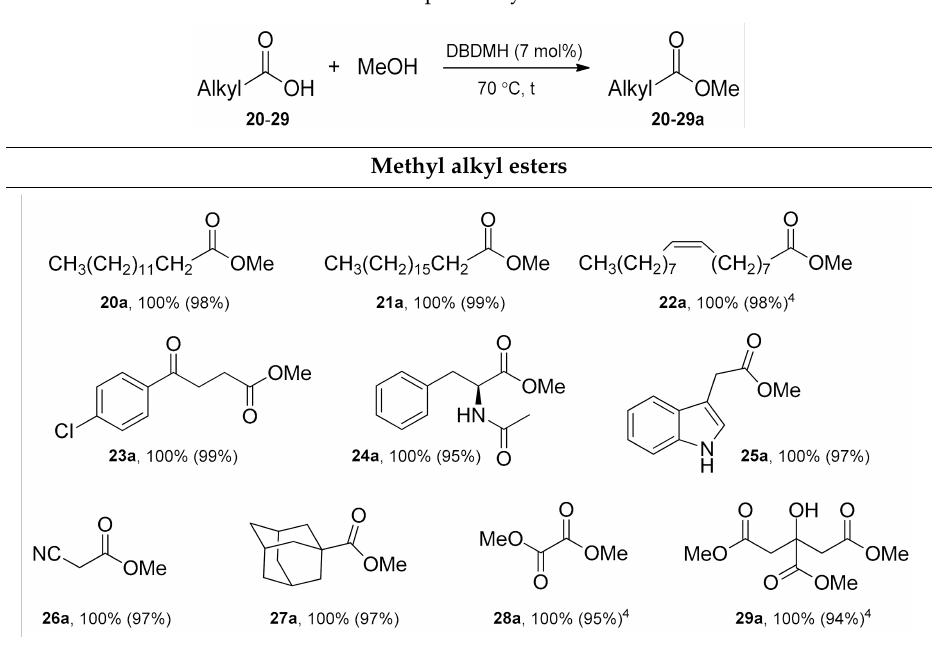
Table 5. Scope of alkyl acids 1,2,3 .